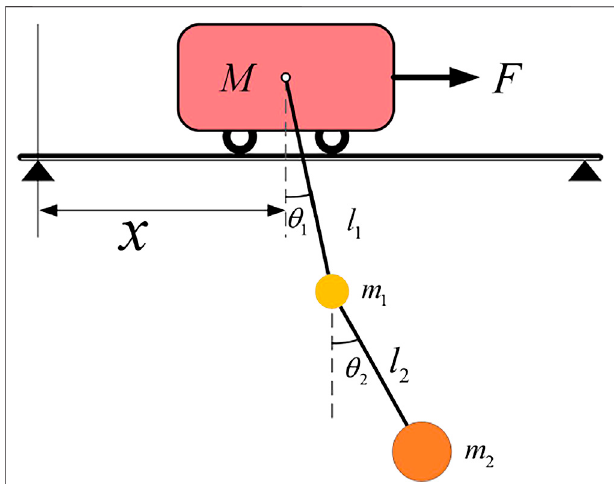
FIGURE 2 | Simpli fi ed model of the crane with